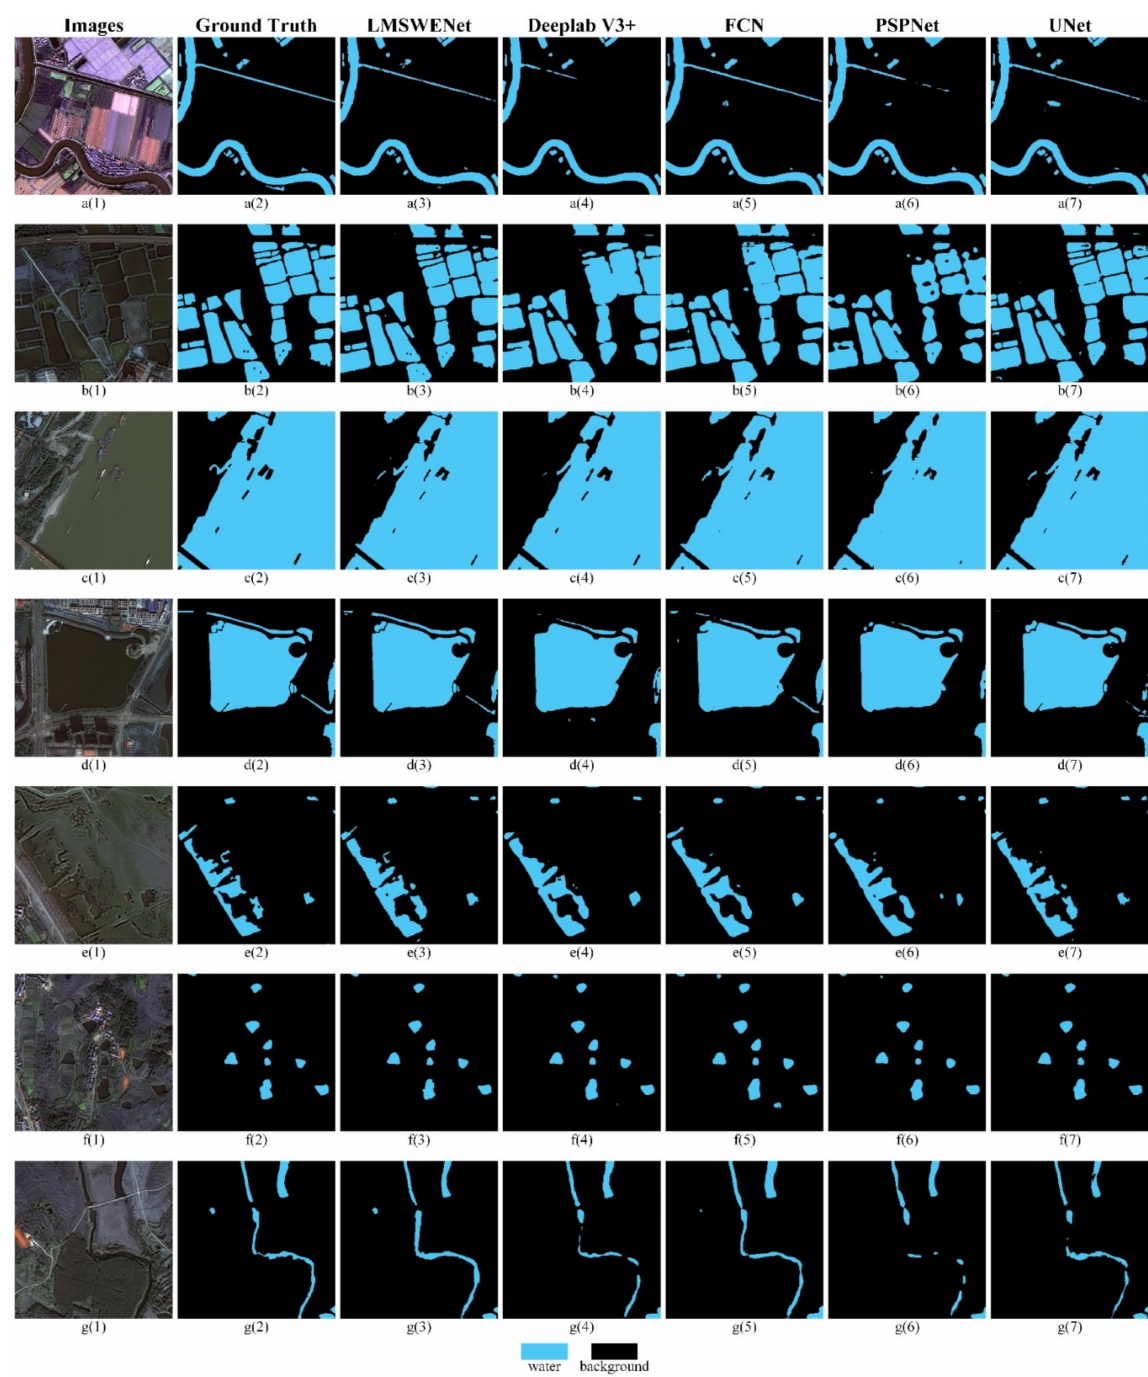
Figure 9. Land surface water information extraction results for different water types. ( a ( 1 )) is the raw image of artificial ditches; ( a ( 2 – 7 )) are the water areas extracted from ( a ( 1 )) using manually labeling, LMSWENet, DeeplabV3+, FCN, PSPNet, and UNet, respectively; ( b ( 1 )– g ( 7 )) are the water areas extracted from various types of water with agricultural water, riverside, lakes, open pools, puddles, and tiny streams,